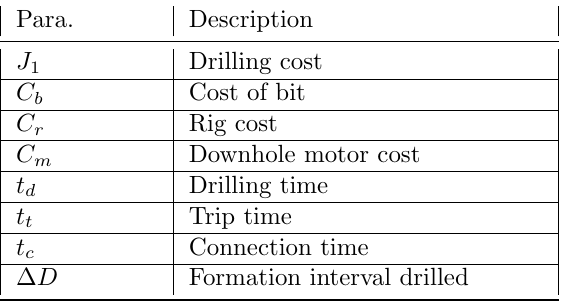
Table 3: Drilling parameters used in Section 6 to approximate the friction factor in this phase. The bottom hole pressure P bhp is then calculated by P bhp = P h + P Loss . Therefore, to make the well safe and reduce the drilling risks, the bottom hole pressure should be within the P frac and P pore ,